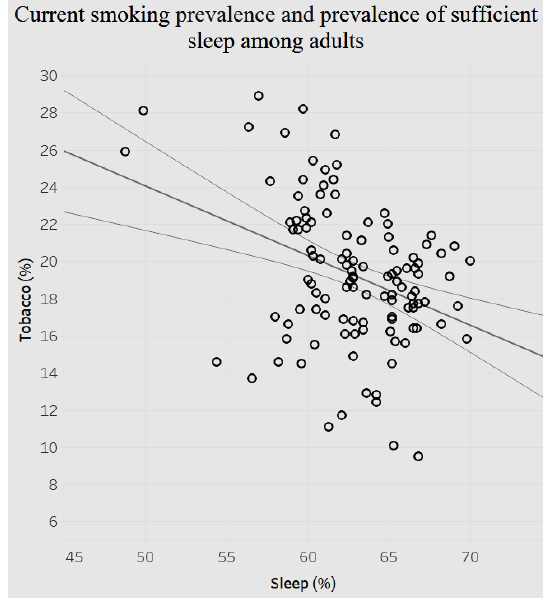
Figure 17. Current smoking prevalence by presence of sufficient sleep among adults.